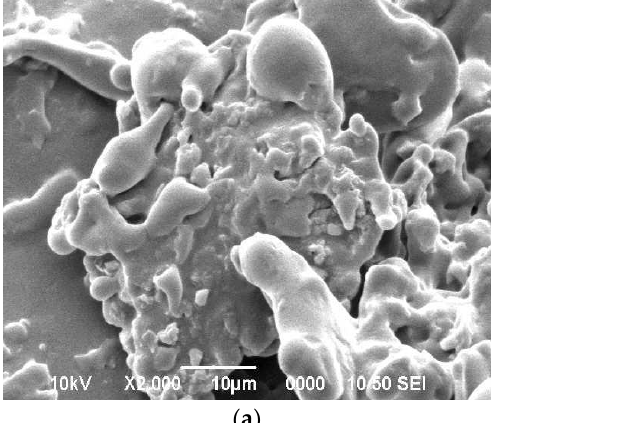
quinoa stalks. The analysis revealed that glucose represented over 90% of the EPS produced